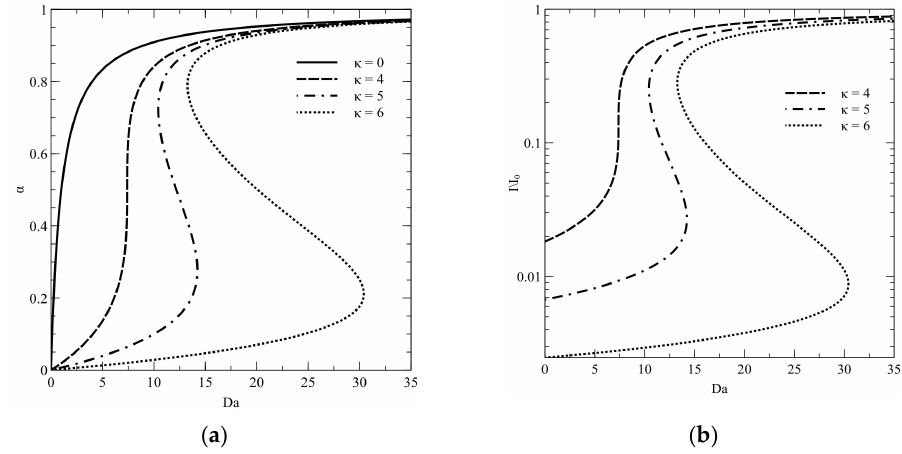
Figure 2. Branches of steady states for different absorbance of the liquid layer: ( a ) the substrate conversion degree; ( b ) relative light incident on the catalyst surface. conversion degree; ( b ) relative light incident on the catalyst